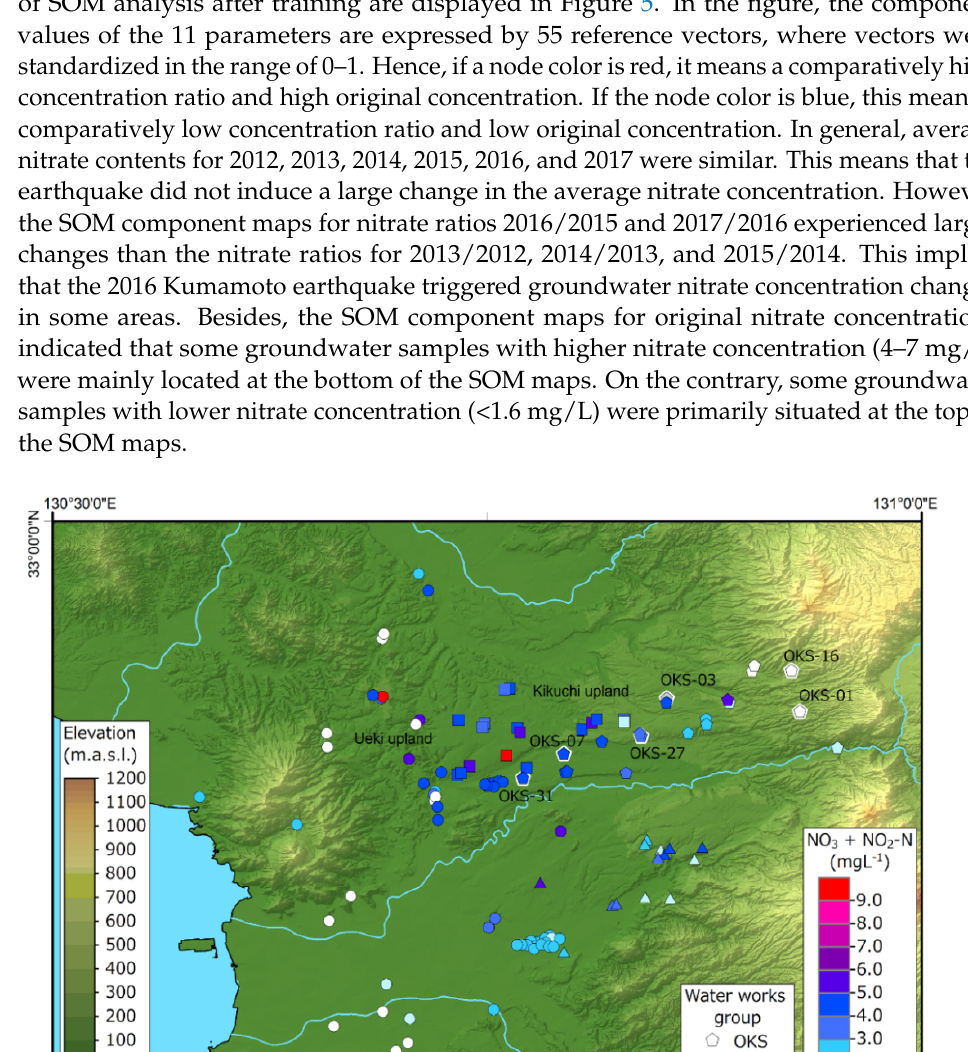
Figure 5. Self-organizing maps (SOM) component planes for 11 nitrate variables.